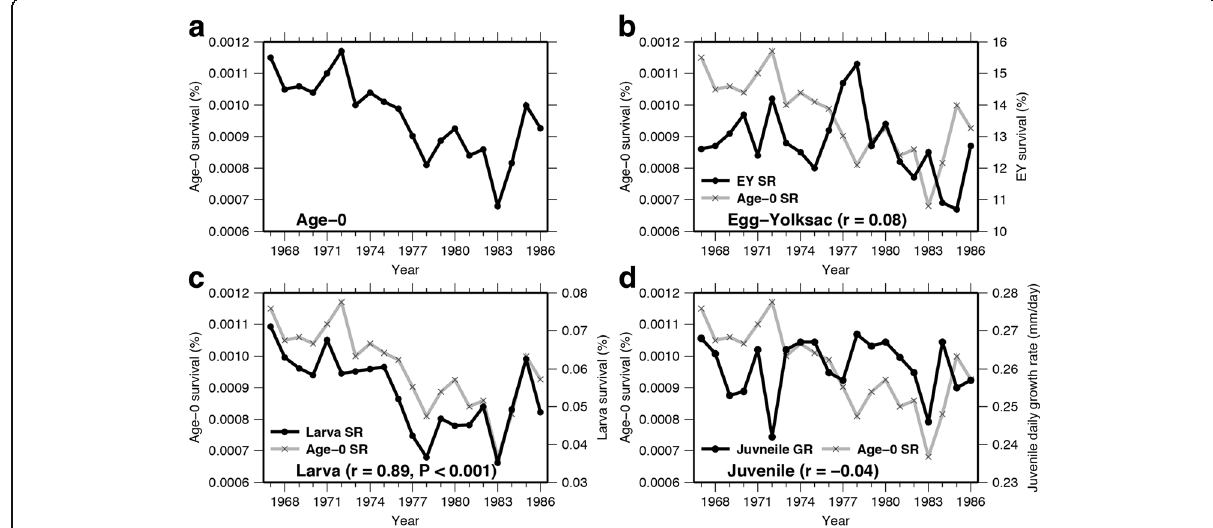
Fig. 5 Time series of simulated anchovy age-0 and stage-specific survivals. Age-0 survival is shown in a as black line and the other panels as a gray line. b Egg – yolk-sac stage survival (black line with closed circles), c larval stage survival (black line with closed circles), and d juvenile daily growth rate (black line with closed circles) from 1967 to 1986 of the historical simulation